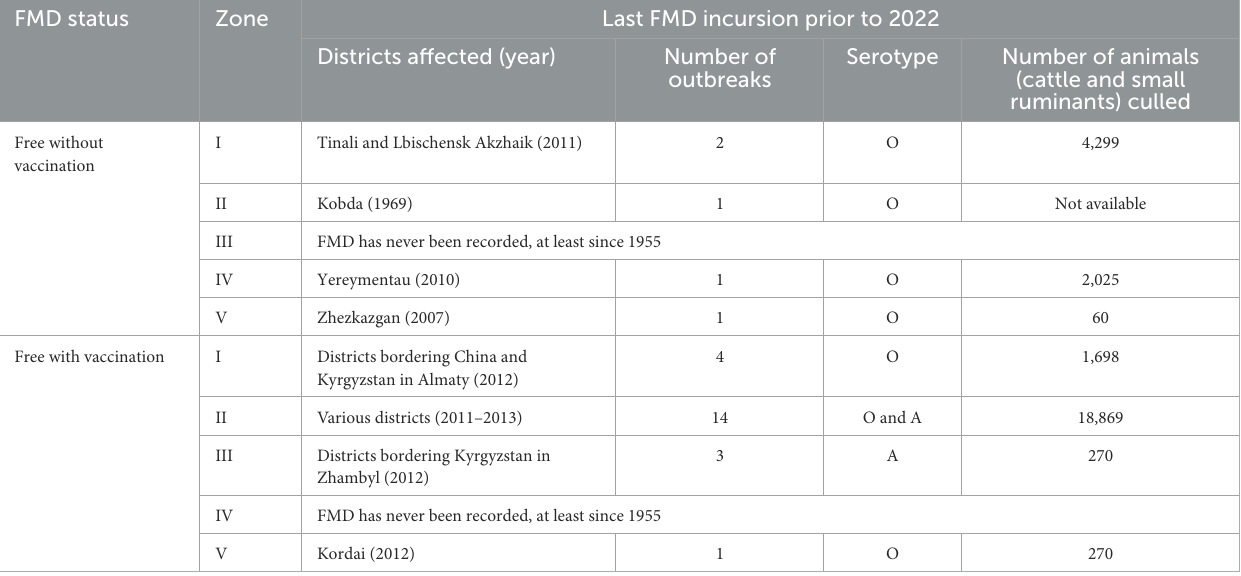
TABLE 1 Epidemiological features of the last foot-and-mouth disease (FMD) outbreaks reported in Kazakhstan in each control zone and before